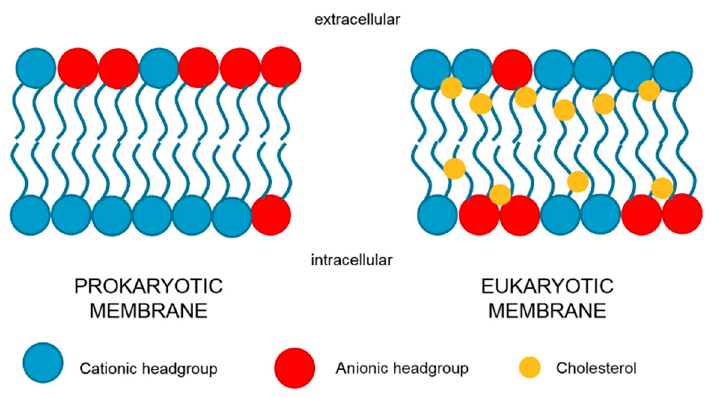
Figure 3. Lipid composition and distribution of prokaryotic and eukaryotic plasma membrane. Negatively charged phospholipids are enriched in the outer layer of prokaryotic membranes and in the inner layer of eukaryotic membranes. Cholesterol, a constituent of eukaryotic cells, stabilizes and protects the membrane from the colistin detergent activity.